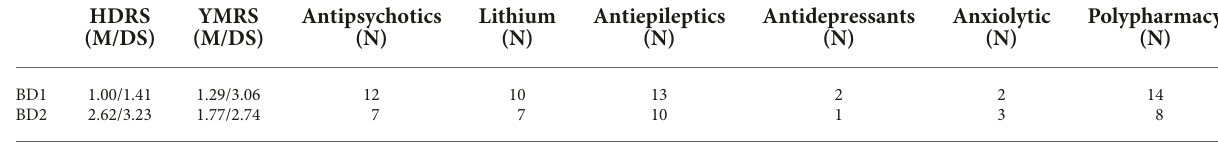
TABLE 2 Details on BD1 and BD2 patients’ scores on HDRS and YMRS and current pharmacotherapy. HDRS